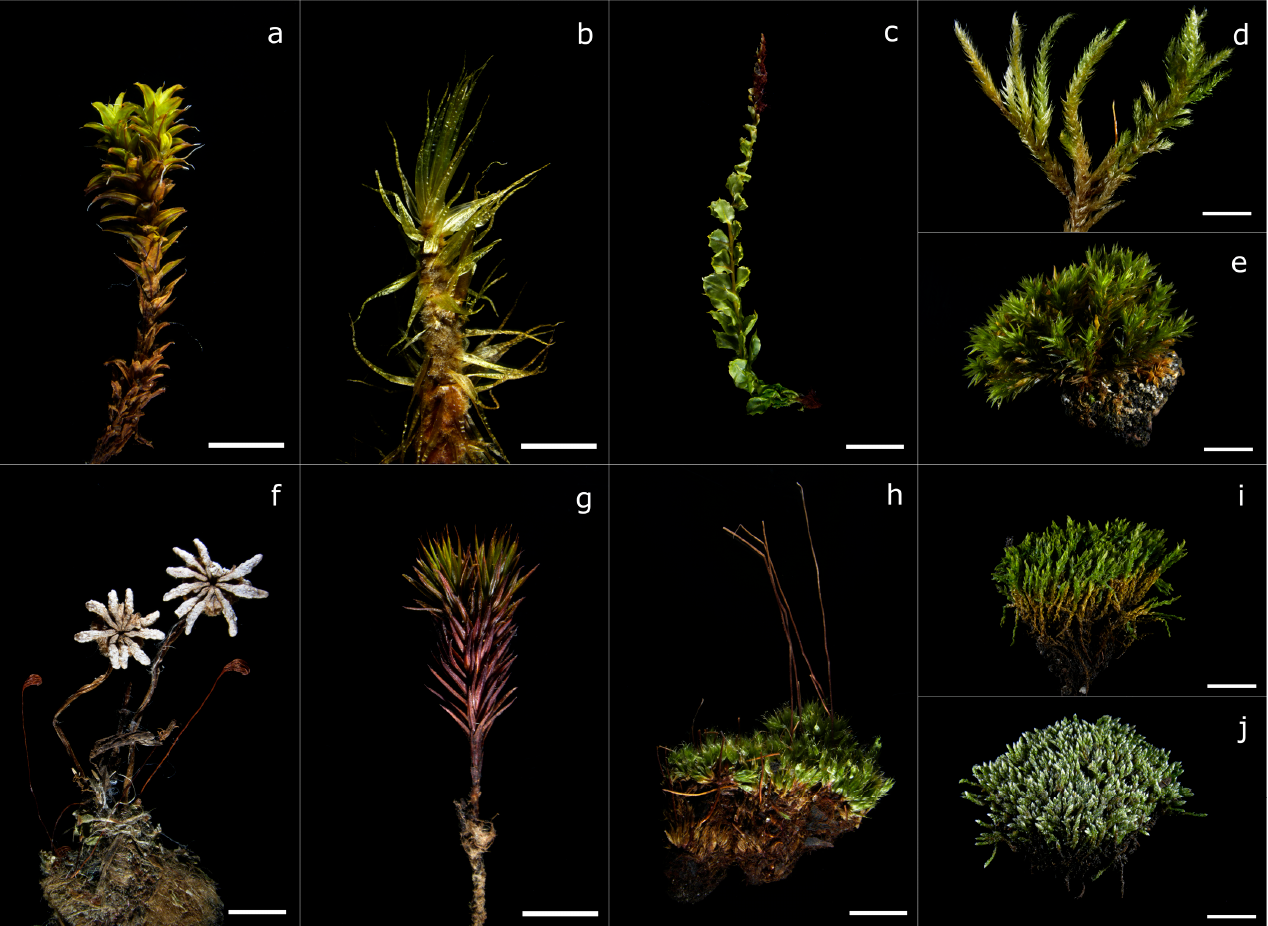
Figure 2. Figure of some of the sampled mosses; # indicates the sampling location, described in detail in Figure 1. ( a ) Tortula calcicolens (#24), ( b ) Dicranum polysetum (#19), ( c ) Plagiomnium cuspidatum (#9), ( d ) Homalothecium philippeanum (#8), ( e ) Orthotrichum speciosum (#21), ( f ) Marchantia polymorpha (#16), ( g ) Polytrichum piliferum (#4), ( h ) Bryum cf. badium (#6), ( i ) Bryum × intermedium (#17), ( j ) Bryum argenteum (#13). Scale bar = 5 mm.